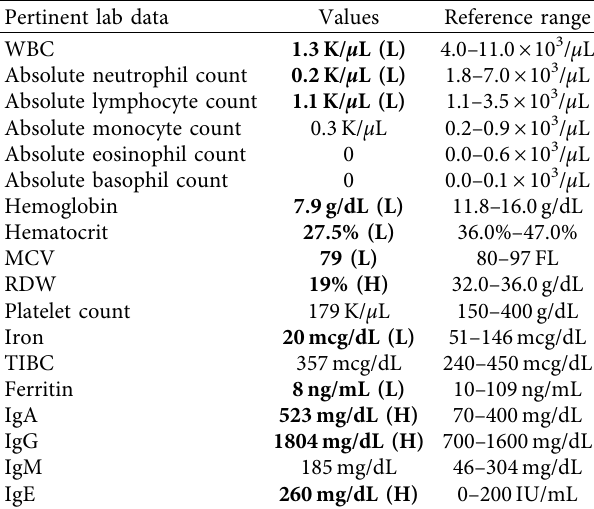
Table 1: Pertinent lab values at initial